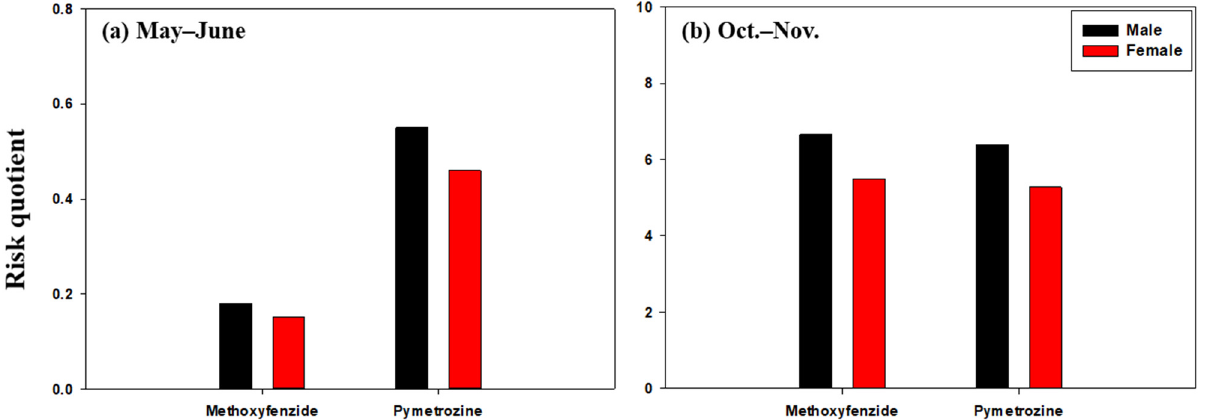
Figure 4. Risk quotient for methoxyfenozide and pymetrozine in cabbage collected in ( a ) May–June and ( b ) October–November.